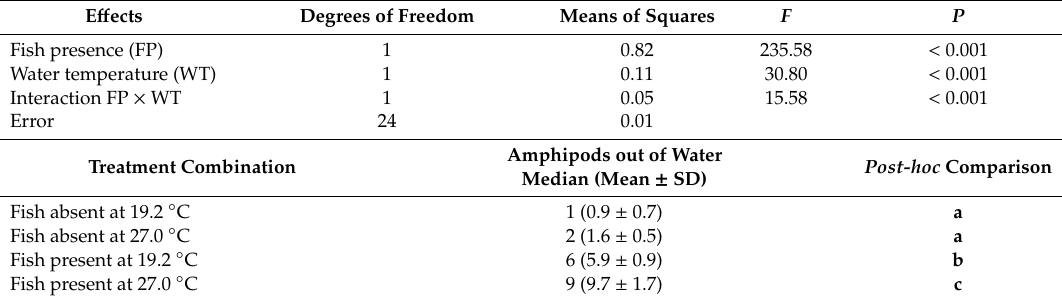
Table 1. Analysis of variance (two-way ANOVA) testing the e ff ects of predator presence, water temperature and their interaction on the number of amphipods leaving the aquarium water (interpreted as experimental predator avoidance). The median and the average number of amphipods out of the water, the standard deviation and the results of the Tukey post-hoc test are shown. Di ff erent letters in the ‘ Post-hoc comparison’ column indicate statistically significant di ff erences among the treatments. E ff ects Degrees of Freedom Means of Squares F P Fish presence (FP) 1 0.82 235.58 < 0.001 Water temperature (WT) 0.11 Interaction FP × WT Amphipods out of Water Median (Mean ± SD)